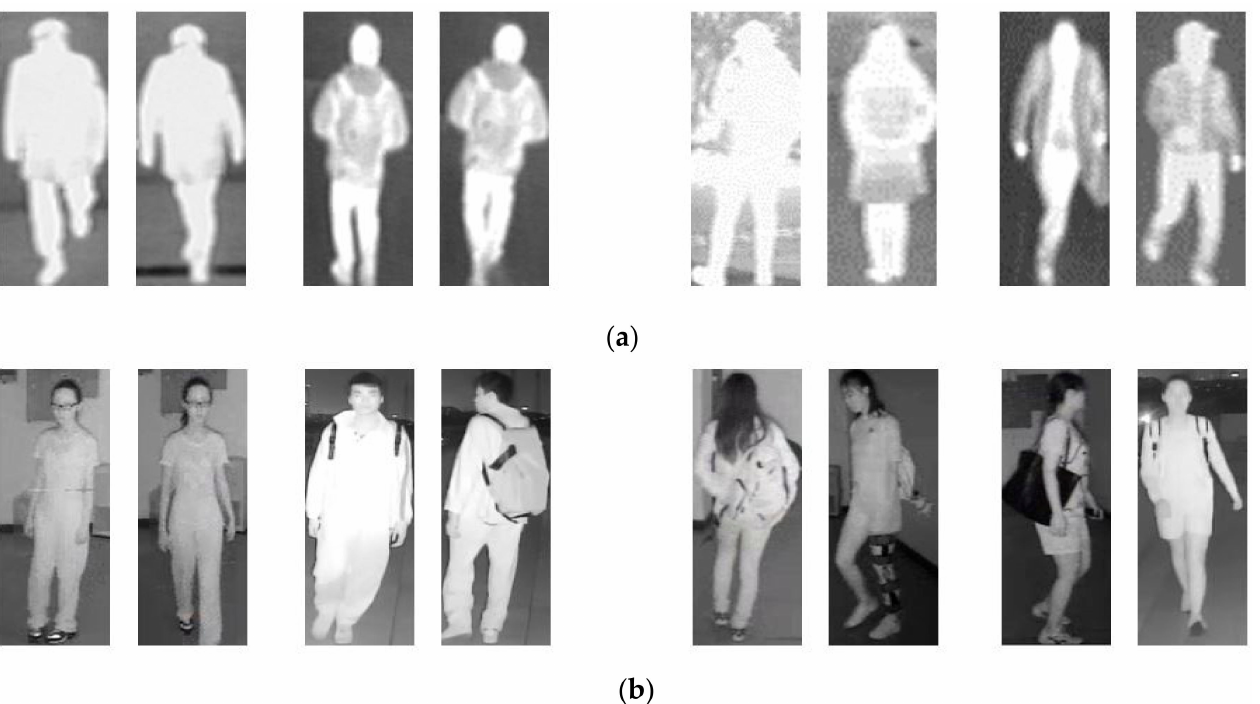
Figure 7. Experiment dataset examples. ( a ) DBPerson-Recog-DB1 thermal dataset and ( b ) Sun Yat-sen University multiple modality Re-ID (SYSU-MM01) IR dataset. In ( a , b ), two pairs from the left show the same persons, whereas the remaining two pairs present different persons. In each pair, left and right images show the enrolled and input query images,